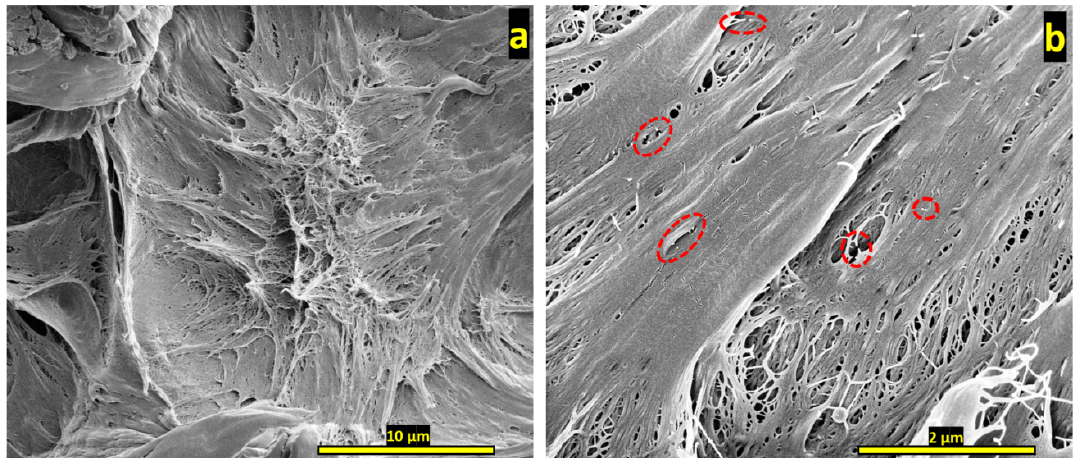
Figure 7. SEM images of iPP cross-sections after Mode I tensile testing at different magnifications. ( a ) Plastic deformation of stretched polymer at 10,000 × magnitude and ( b ) crazing of the polymer at 50,000X magnitude. The dashed red circles show areas of crack bridging by microfibers.